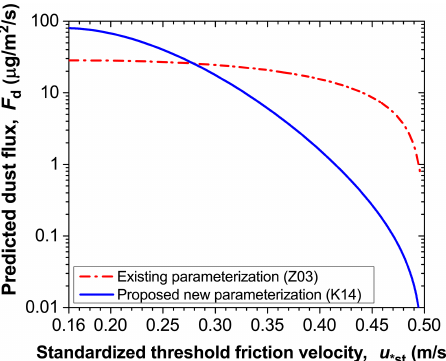
Figure 1. The vertical dust flux ( F d ) as a function of the soil’s stan- dardized threshold friction velocity ( u ∗ st ) in CESM for the default Z03 dust flux parameterization (Eq. 6; dash-dotted red line), and for the K14 parameterization (Eq. 7; solid blue line). Results are shown for u ∗ = 0.50ms − 1 and for f clay = 15 %, which is a typical value for dust emitting regions (see Fig. S1 in the Supplement). The pre- dicted dust fluxes include the global tuning factors that eliminate the bias against AERONET AOD measurements for simulations I and IV, respectively (see Eq. 1 and Sect.